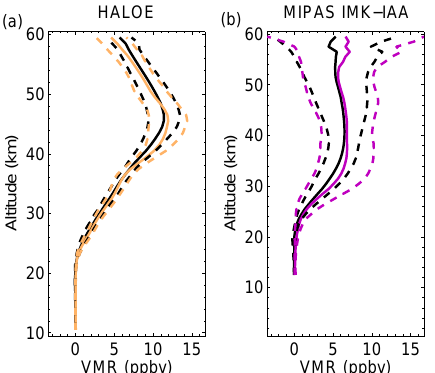
Figure 3. Mean NO profiles (in ppbv) for coincident diurnally scaled ACE-FTS (black) and HALOE (left panel) and MIPAS IMK- IAA (right panel) measurements and corresponding measurement standard deviations (dashed lines). Coincidence criteria for HALOE comparisons are within 3h and 500km and are within 3h and 100km for MIPAS IMK-IAA